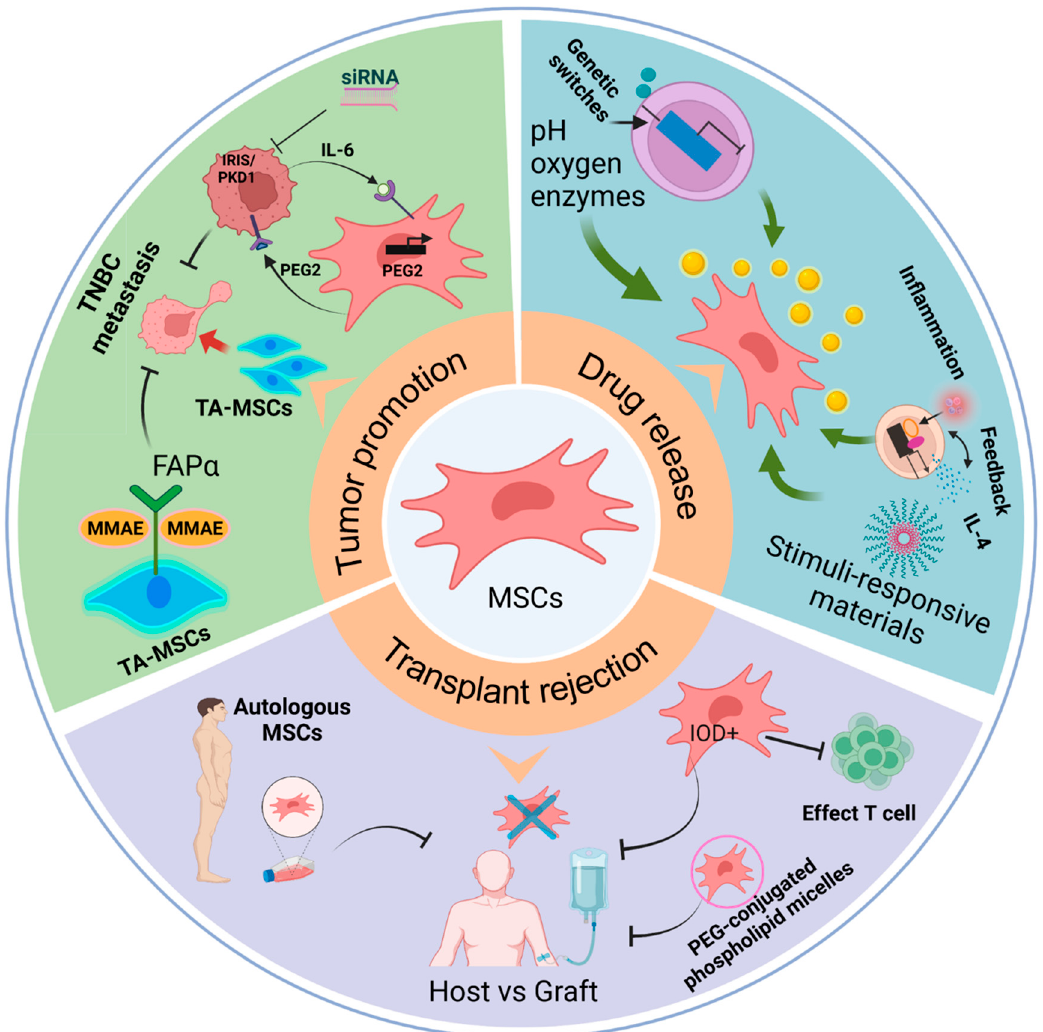
Figure 3. The challenges and proposed solutions for using mesenchymal stem cells (MSCs) in the treatment of TNBC, including transplant rejection, tumor promotion, and drug release